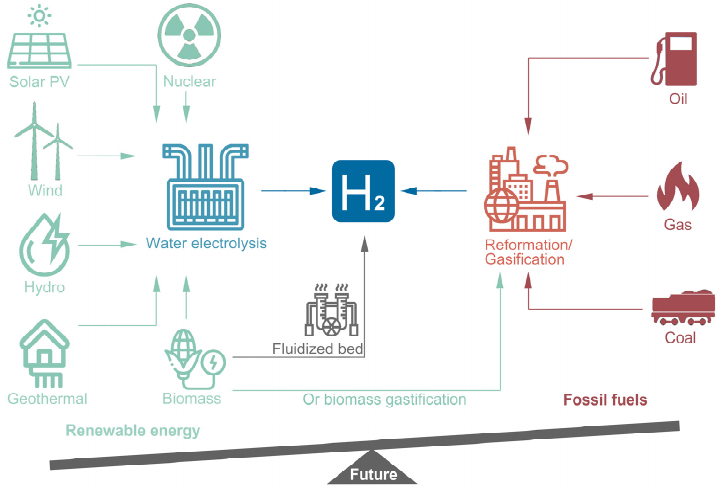
Figure 1. Hydrogen production from different resources via different technical routes. Left: blue hydrogen. Right: gray